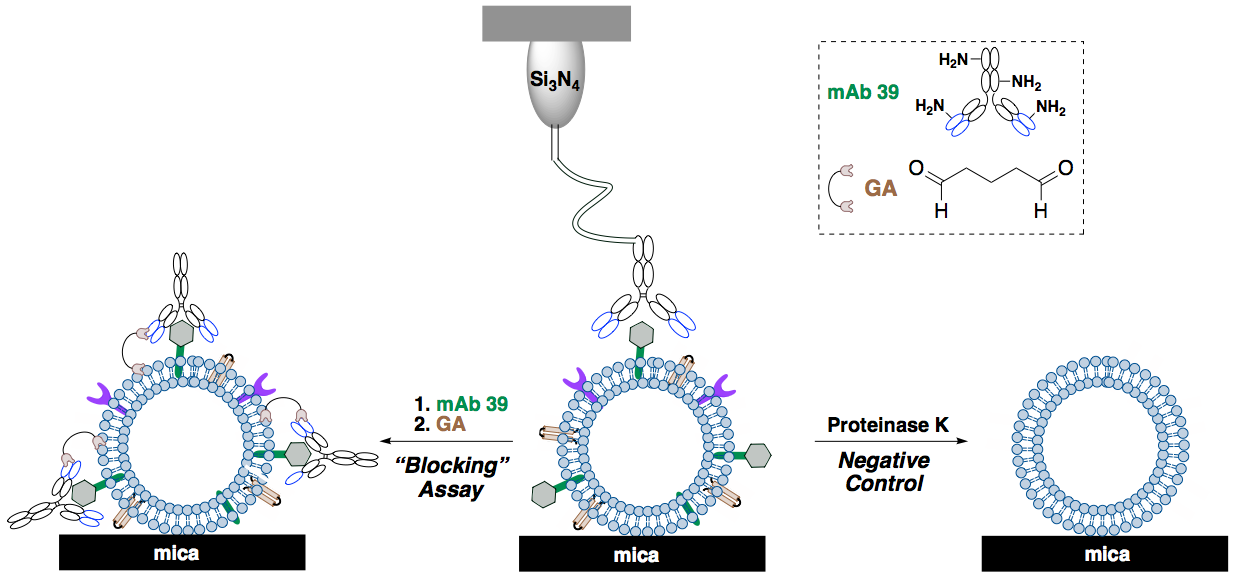
Figure 4. Immobilization of Ex-TcT, “TS-free” Ex-TcT (negative control), and Ex-TcT ≈ mAb 39 immune complexes (“blocking” assay) on mica sheets.